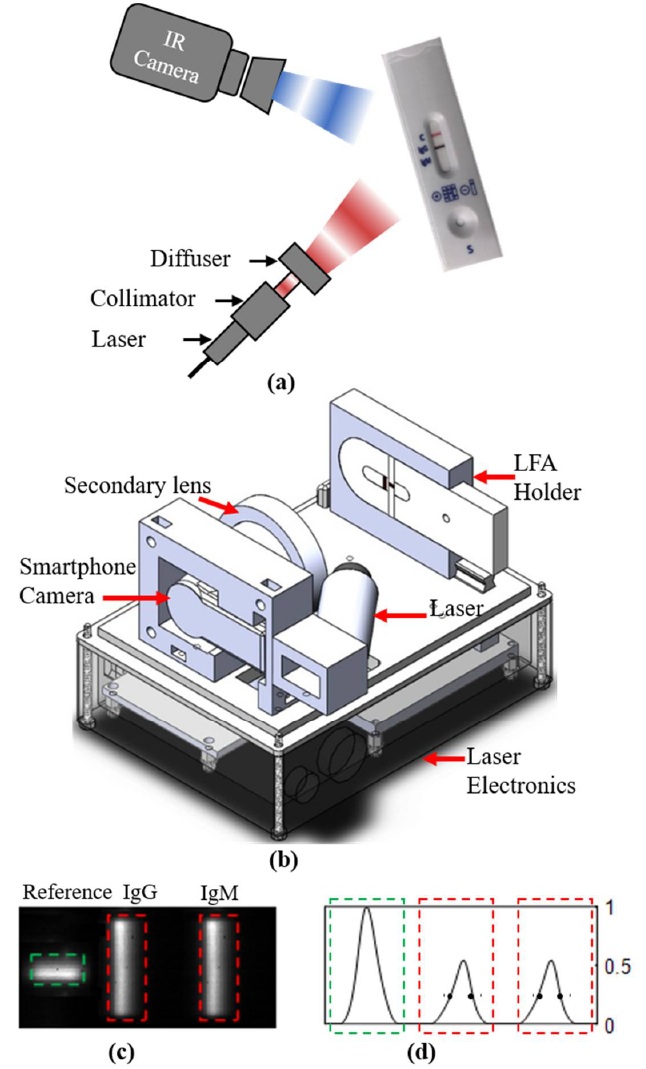
Figure 1. Schematic showing ( a ) the working principle and ( b ) exploded view of handheld thermo- photonic device used for interpretation of assays. ( c ) Lock-in thermography (LIT) amplitude image of an assay. The green rectangle shows the reference IgG and red rectangles show the test IgG and IgM bands. ( d ) Three gaussian-shaped curves produced by averaging pixels along the longer axis direction of reference (green rectangle) and IgG and IgM bands (red rectangles). Amplitude metric was calculated by averaging the intensity between two solid dots on each IgG and IgM curves.